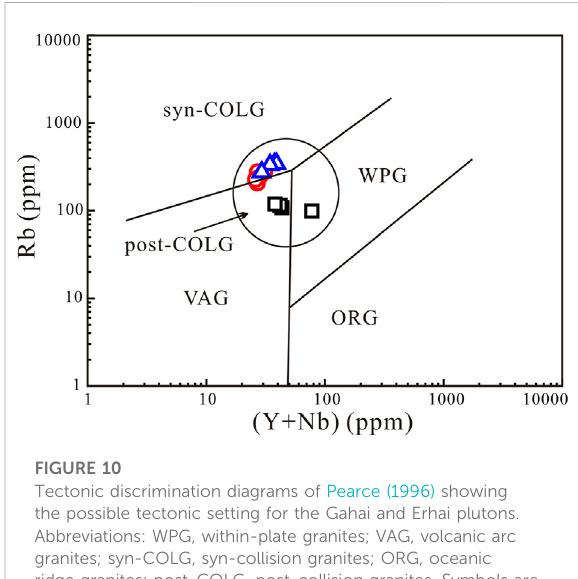
FIGURE 10 Tectonic discrimination diagrams of Pearce (1996) showing the possible tectonic setting for the Gahai and Erhai plutons. Abbreviations: WPG, within-plate granites; VAG, volcanic arc granites; syn-COLG, syn-collision granites; ORG, oceanic ridge granites; post-COLG, post-collision granites. Symbols are the same as in Figure